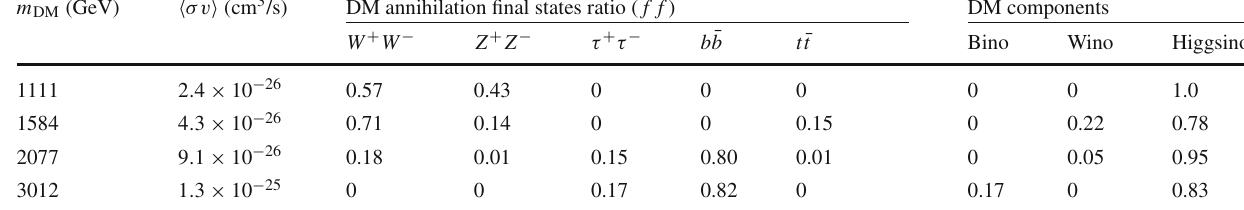
Table 1 Four benchmark points, one point for each case (decoupled case, A -mediated case, squark and stop coannihilation cases) with largest (cid:4) σv (cid:5)